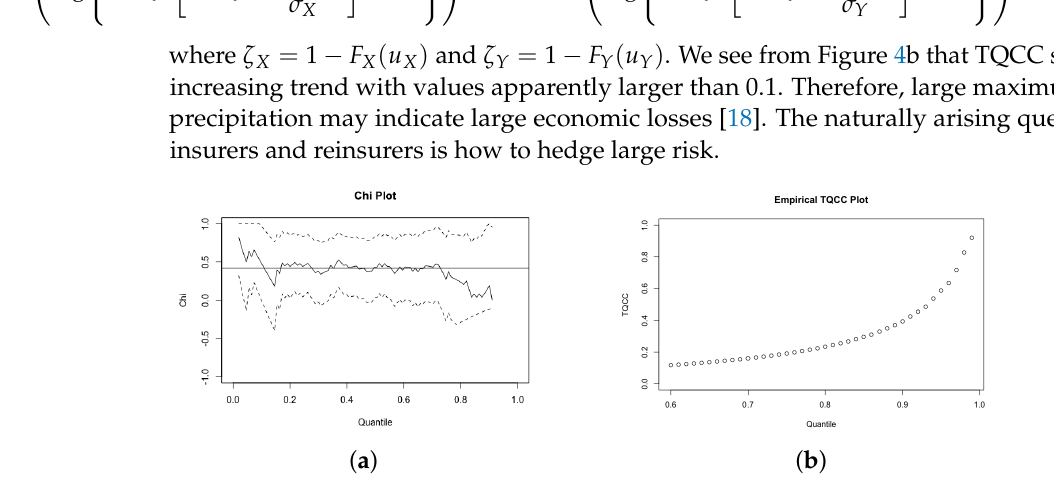
Figure 4. The empirical tail dependence measures ( a ) the Chi plot χ n ( u ) and ( b ) the tail quotient correlation coefficient q ( u ) . The solid lines and dotted lines show the estimate and 95% pointwise confidence intervals, respectively. The estimate of the tail dependence index (cid:98) χ = 2 − 2 0.6734 = 0.405 is indicated by the horizontal line using the bivariate logistic extreme value